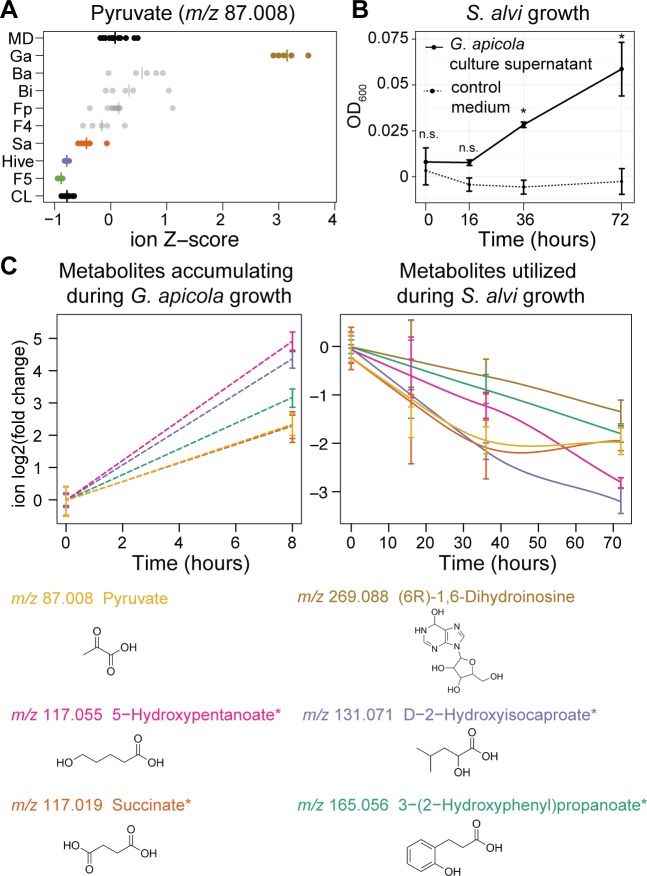
Cross-feeding between G. apicola and S. alvi.(A) Evidence for cross-feeding of pyruvate in the honey bee gut. Z-score transformed ion intensities revealed that the ion annotated as pyruvate accumulated in bees mono-colonized with G. apicola but was depleted in hive bees, CL bees, and bees mono-colonized with S. alvi and Firm-5. (B) Growth improvement of S. alvi in G. apicola-conditioned medium. S. alvi was grown in pollen-conditioned medium in the presence (black line) or absence (dashed line) of G. apicola culture supernatant (50%, v/v). Growth was determined based on OD600 at time points 0 h, 16 h, 36 h, and 72 h. n.s., not significant; * P < 0.05 (Welch’s t test, Benjamini and Hochberg adjusted [BH adj.]). (C) Six potentially cross-fed ions that accumulated during in vitro growth of G. apicola (left subpanel) and were consumed by S. alvi when it was grown in the presence G. apicola culture supernatant (right subpanel). Data from panels B and C come from the same experiment. Smoothed lines are added for interpretation purposes only in panel C and are dashed in the left subpanel because they are drawn through two points only. Error bars represent the standard deviation based on three replicate cultures. Chemical structures of the first annotation of each ion are shown. Asterisks indicate ions with ambiguous annotations. The numerical data of panel A can be retrieved from S8 Data. All other values are available in S1 Data.